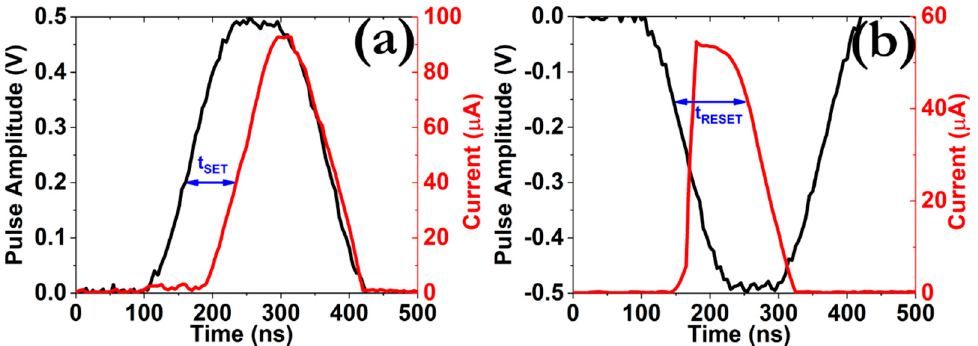
Figure 3. Measured transient current responses (red line) as a function of time during the application of ( a ) + 0.5 V/100 ns and ( b ) − 0.5 V/100 ns square pulses (black line). A limit of I CC = 1 mA was imposed in all cases.